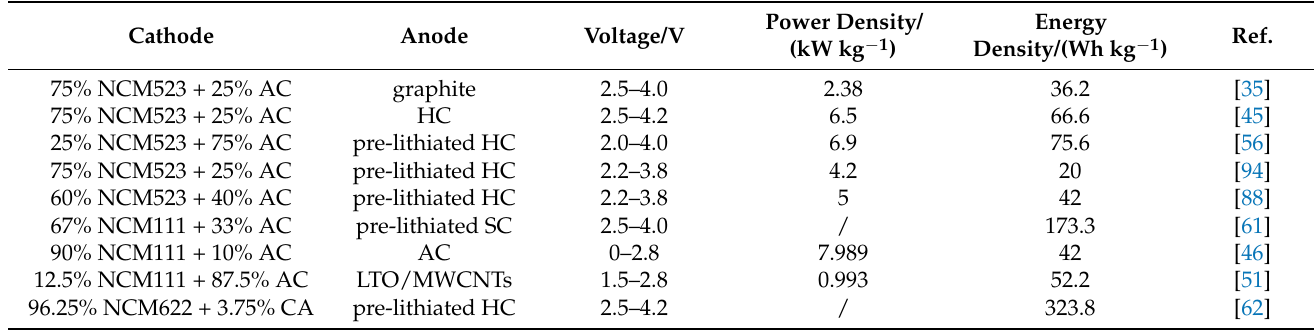
Table 2. Structure and performance of selected NCM-based